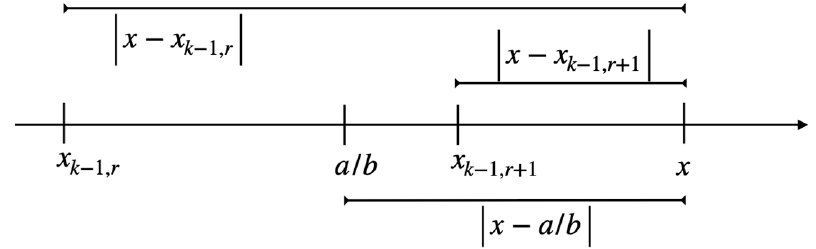
Figure 14. Distances within an interval of semiconvergents (k odd).